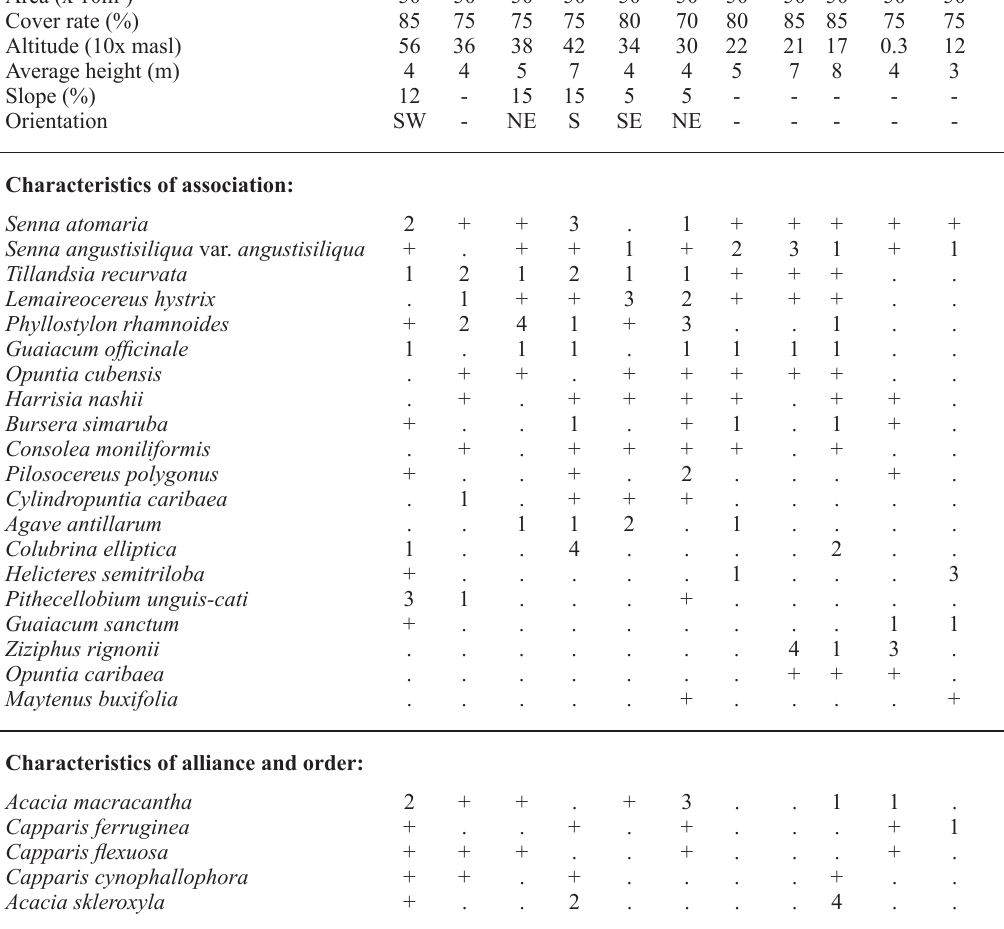
Phyllostylo rhamnoidis-Prosopidetum juliflorae ass.